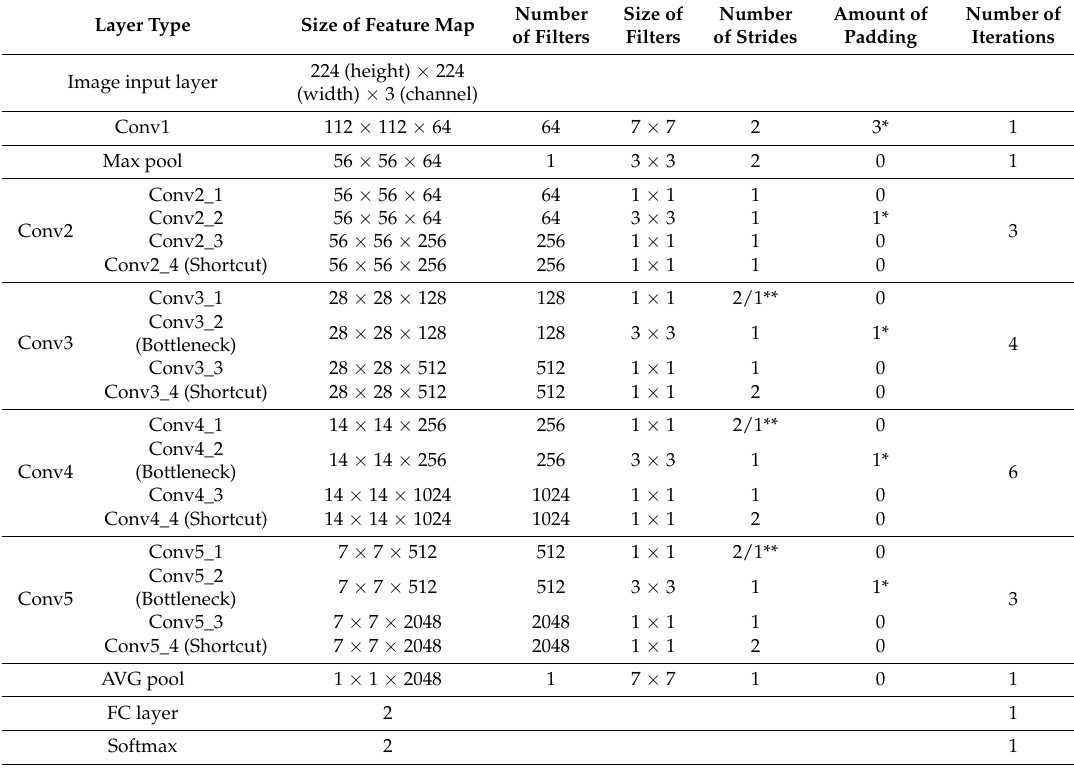
Figure 8. The structure of ResNet-50 [70]. Conv, MaxPool, and AVG pool represent convolutional layer, max pooling layer, and average pooling layer, respectively. Table 3. Output size, numbers and sizes of filters, number of strides, and amount of padding in our deep residual CNN structure (3* indicates that 3 pixels are included as padding in left, right, up, and down positions of input image of 224 × 224 × 3, whereas 1* indicates that 1 pixel is included as padding in left, right, up, and down positions of feature map) (2/1** indicates 2 at the 1st iteration and 1 at the 2nd iteration) (For the shortcuts in Conv2_4, 3_4, 4_4, and 5_4, the filter of 1 × 1 is used only for the 1st iteration whereas identity mapping is used for the other iterations).